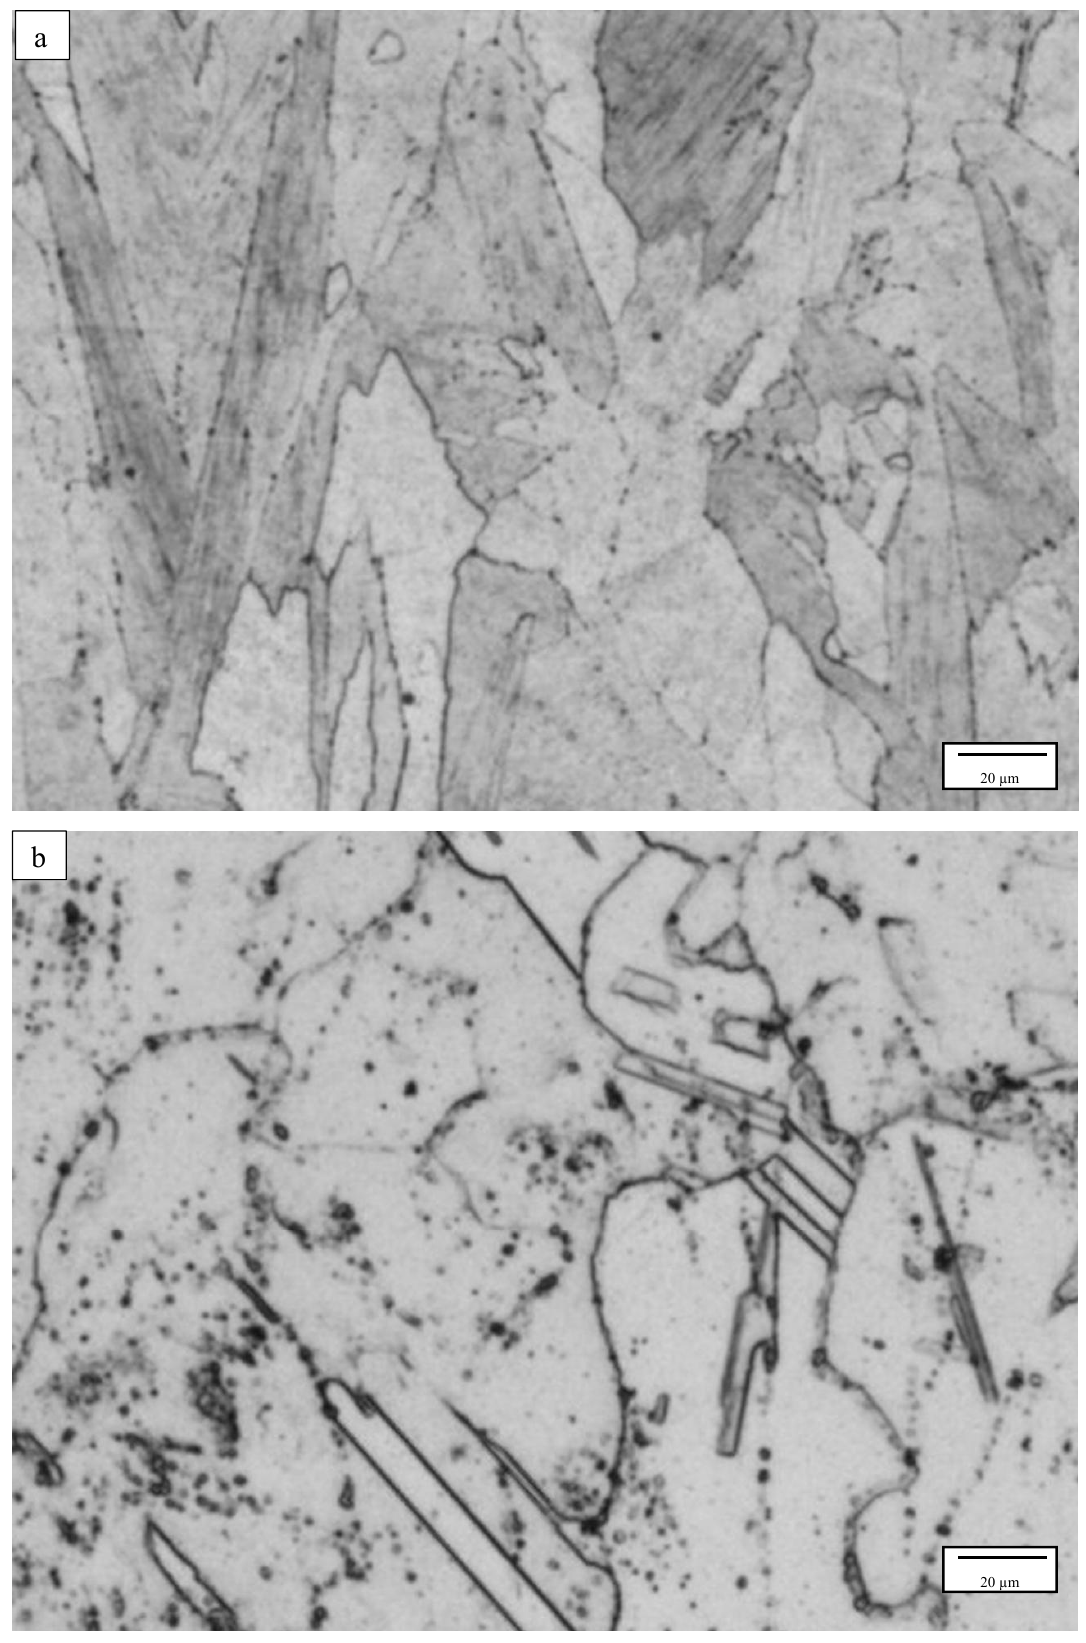
Figure 4. Magnified OM images of Variant 3 ( a ) and Variant 4.2 ( b ).